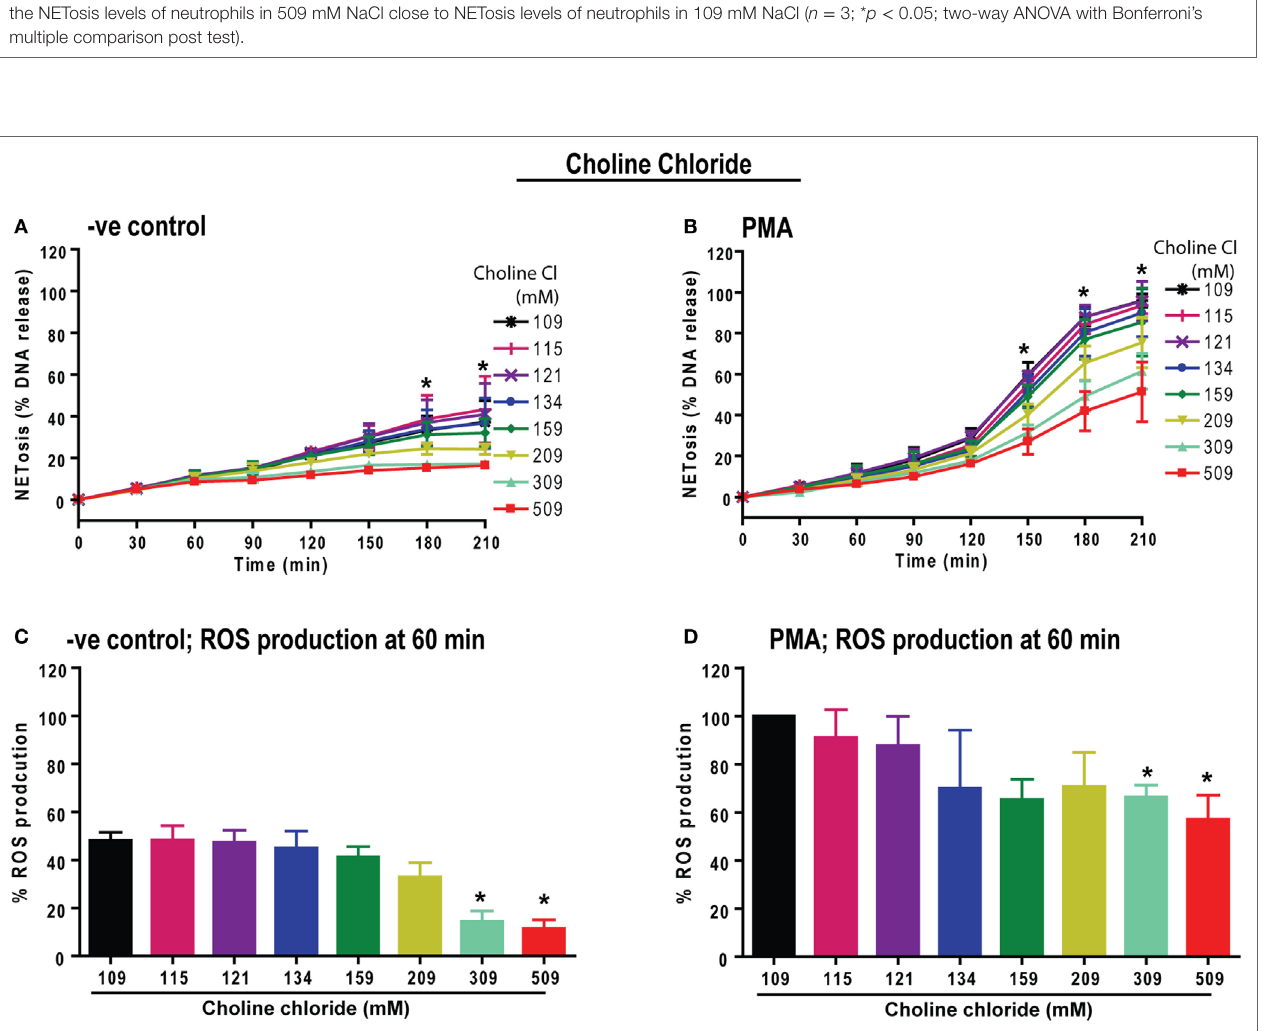
FigUre 3 | Increasing choline chloride suppresses phorbol myristate acetate (PMA)-mediated reactive oxygen species (ROS) production and neutrophil extracellular traps (NETs) release. Neutrophils were resuspended in equimolar choline chloride (ChlCl) containing RPMI media, substituting different concentrations of NaCl. These neutrophils were used for the Sytox Green NETosis and DHR123-based ROS production kinetics by plate reader assays. (a) − ve control neutrophils treated with ChlCl shows dose-dependent suppression of background % DNA release at 309 and 509 mM ChlCl conditions. (B) PMA-treated neutrophils show significant dose-dependent suppression of NET release at 309 and 509 mM ChlCl conditions at time points 150, 180 and 210 min ( n = 3; two-way ANOVA with Bonferroni’s multiple comparison post test). (c) The % ROS production was calculated by considering the PMA-mediated ROS production at normotonic condition as 100% during 60-min time point. At 60 min, background ROS production is suppressed by high ChlCl doses of 309 and 509 mM. (D) PMA-treated neutrophils experience significant suppression of ROS production at the 60-min time point (* p < 0.05; one-sample t -test compared to hypothetical value 100).